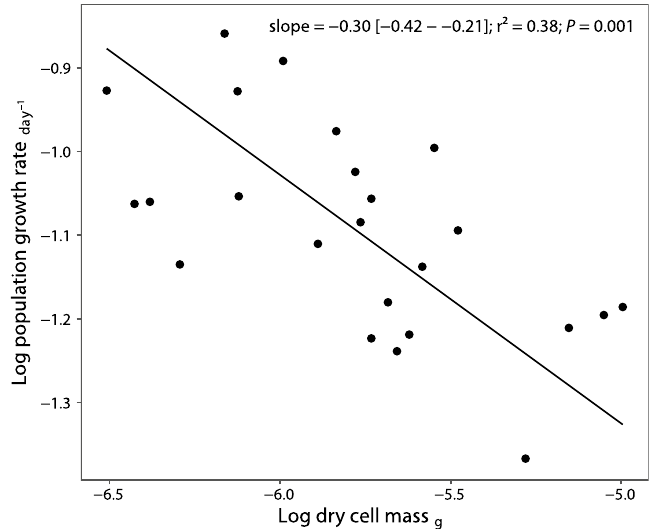
Figure 2. Population growth rate as a function of dry cell mass for the 24 studied species of Micrasterias. Both variables are log-10-transformed. Each dot represents the average value of a given species. The black line represents SMA regression.